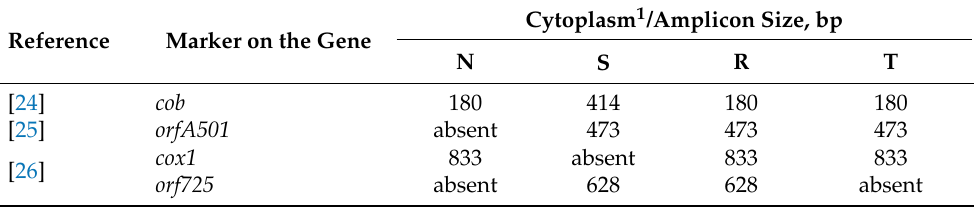
Table 1. Conventional PCR marker system in mitochondrial DNA distinguishing of onion cytoplasm according to the classification proposed by Heavy and Kim [19].